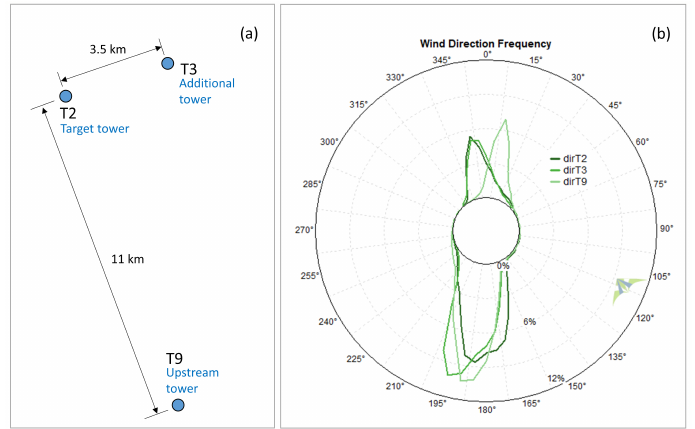
Figure 3. Site characteristics. ( a ) Relative locations of meteorological towers used in this work. ( b ) Wind roses from all